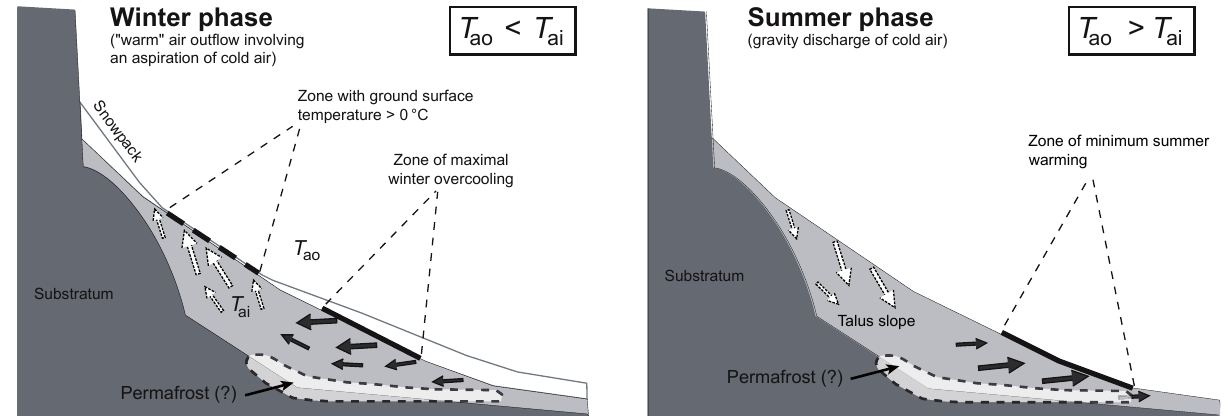
Figure 1. Schematic view of a seasonally alternating air circulation within a talus slope (modified from Morard et al., 2010). T ao and T ai denote air temperature outside and inside the blocky material,